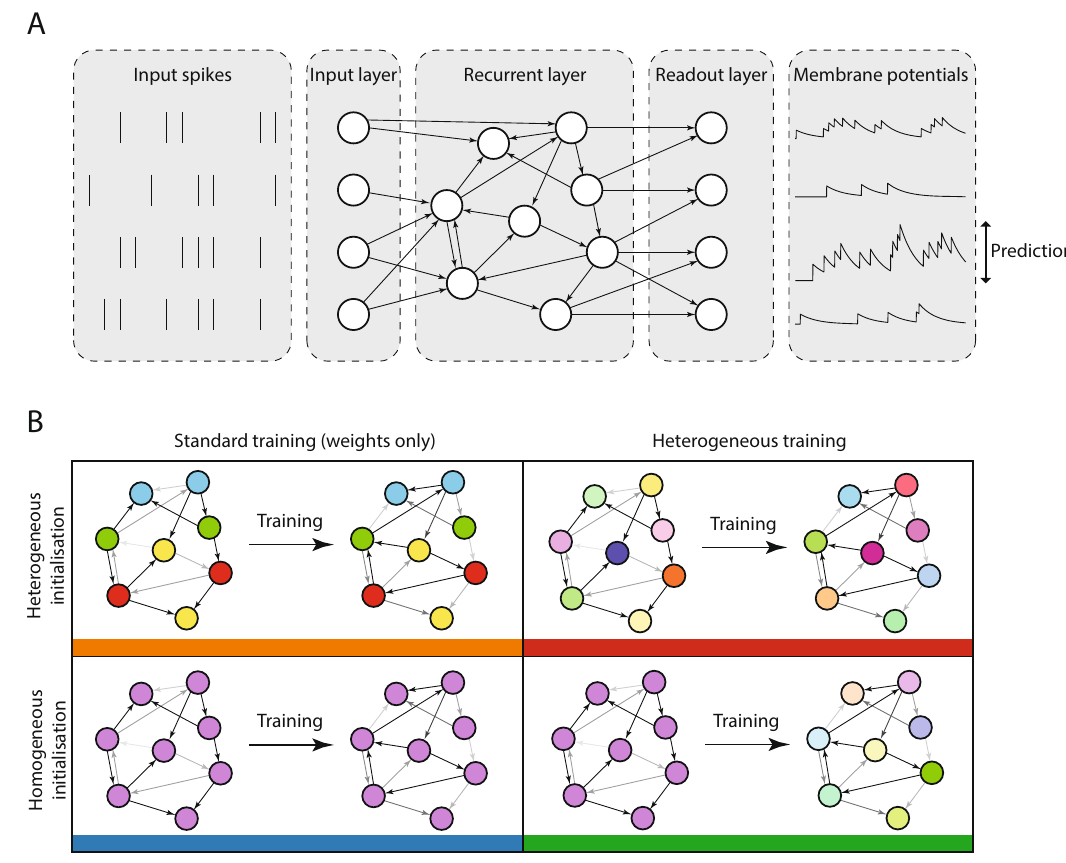
Fig. 1 Diagram of network architecture and training con fi gurations. A Model architecture. A layer of input neurons emits spike trains into a recurrently connected layer of spiking neurons which is followed by a readout layer. B Con fi gurations. Training can be either standard (only the synaptic weights are learned) or heterogeneous (the synaptic weights and membrane and synaptic time constants are learned). The initialisation can be homogeneous (all synaptic and membrane time constants are initialised to the same value) or heterogeneous (synaptic and membrane time constants are randomly initialised for each neuron by sampling them from a given probability distribution). Table 1 Testing accuracy percentage over different datasets and training methods. Initialisation